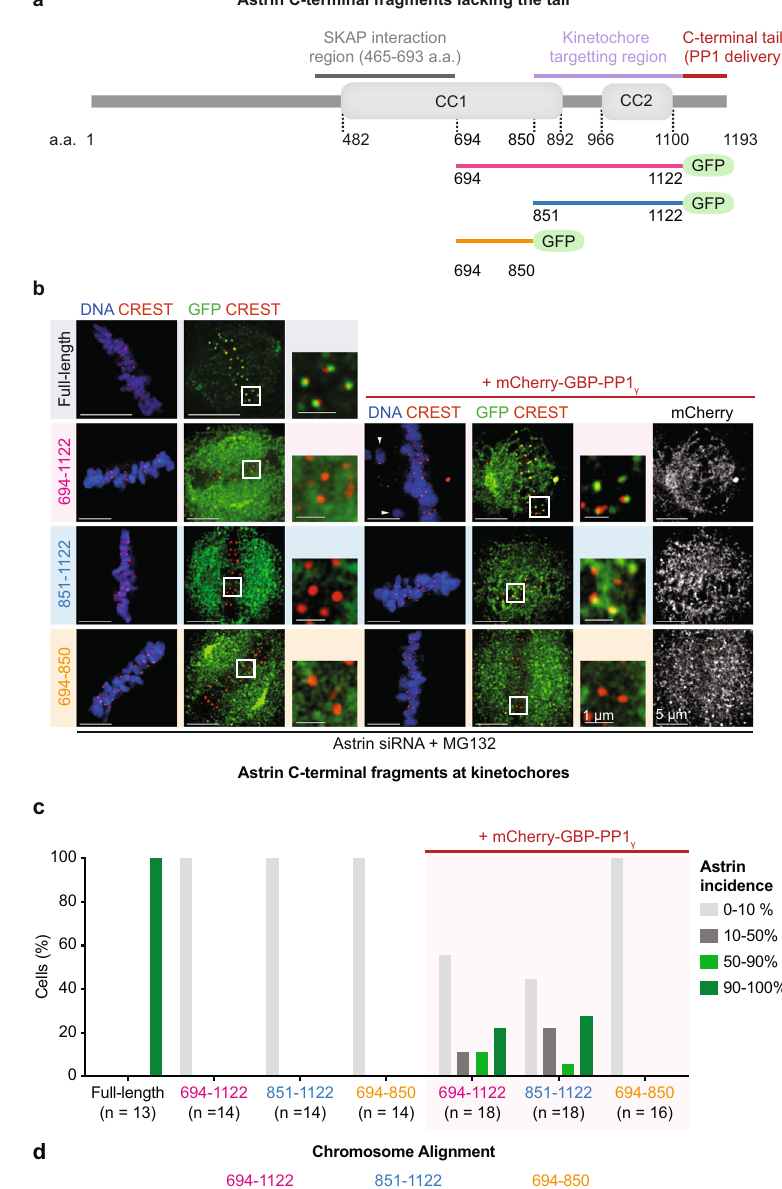
quanti fi cation of Cyclin-B status at kinetochores enriched for SKAP: Kinetochores displaying high levels of Cyclin-B rarely displayed high levels of SKAP, instead, they frequently displayed low or no SKAP at kinetochores (Fig. 6c), demonstrating that Cyclin-B is signi fi cantly reduced at kinetochores enriched for the Astrin-SKAP